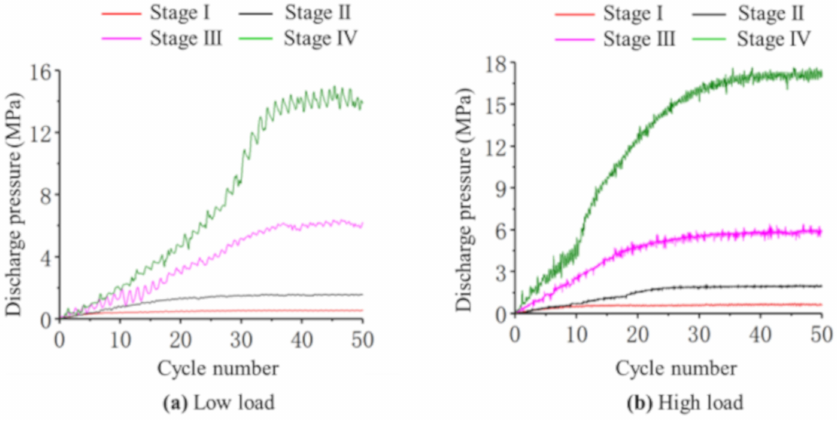
Figure 18. Discharge pressures in all stages under non-standard working